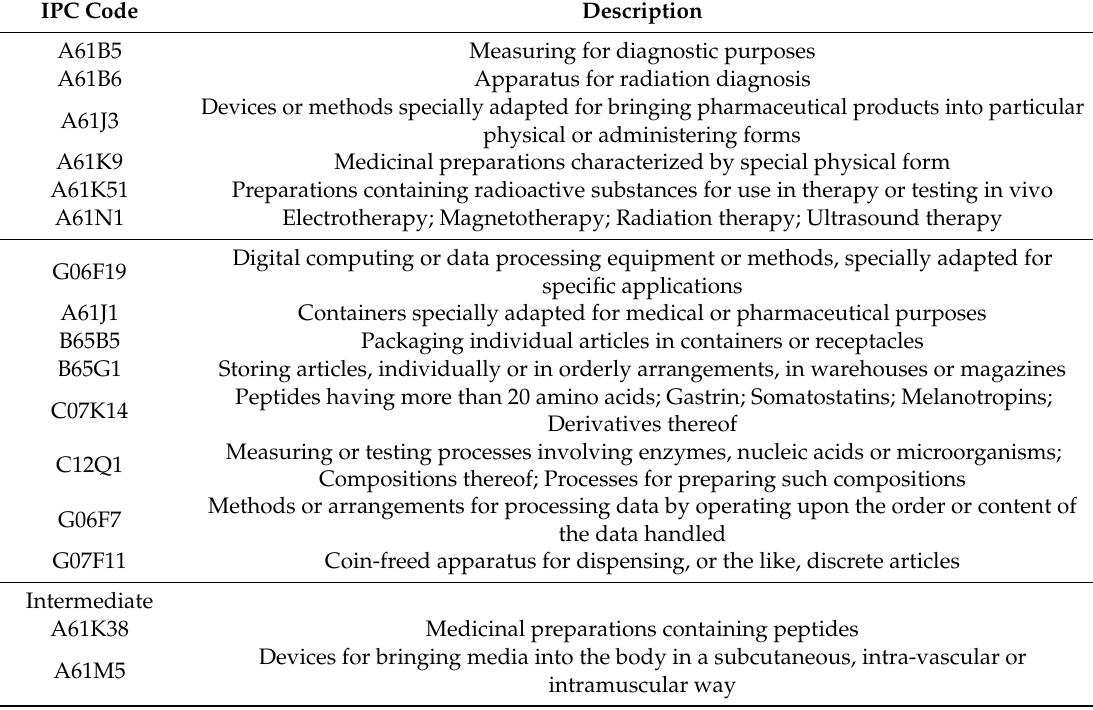
Table A7. Description of IPC codes for the data science-based innovation period